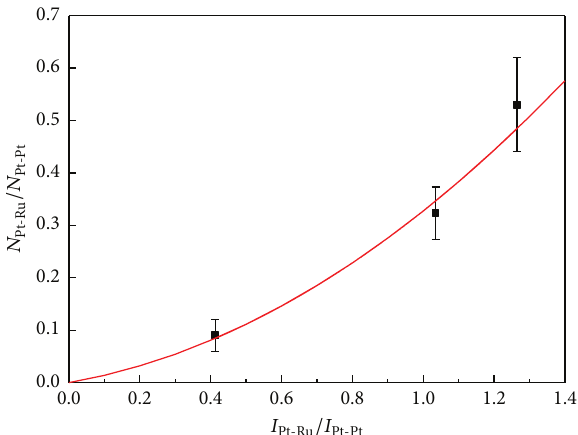
Figure 7: Correlation between the ratio of Pt-Ru to Pt-Pt charac- teristic peak intensity (𝐼 coordination number (𝑁